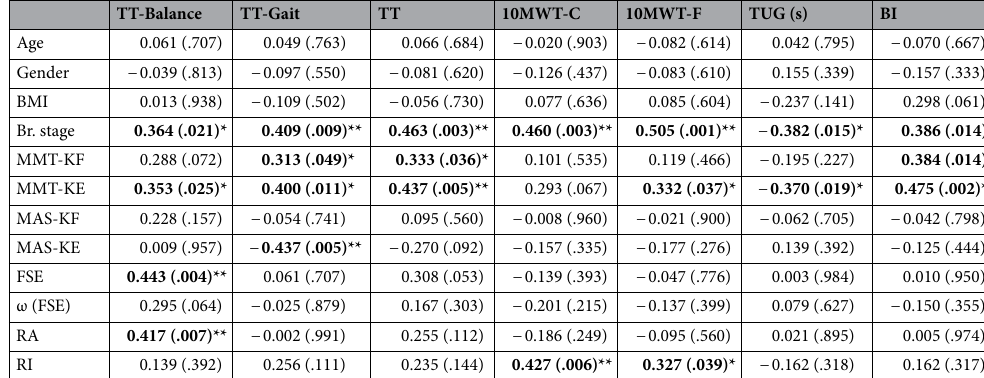
Table 3. Two-tailed Spearman correlation between MAS, pendulum parameters and mobility function. § BMI body mass index; Br. Stage Brünnstrom recovery stage; MMT manual muscle test; MAS modified Ashworth scale; KF knee flexor; KE knee extensor; FSE first swing excursion; ω(FSE) angular velocity of first swing excursion; RA resting angle of the pendulum test; RI relaxation index; TT Tinetti test; TT-Balance balance section of TT; TT-Gait gait section of TT; 10 MWT 10-m walk test; 10MWT-C comfortable speed of 10 MWT; 10MWT-F the fastest speed of 10 MWT; TUG timed-up-and-go test; BI Barthel index. *Correlation is significant at the 0.05 level (2-tailed); **Correlation is significant at the 0.01 level (2-tailed). a The MMT, MAS, and pendulum tests were investigated in the paretic knees (N = 40). b The strength of the monotonic relationship is presented by the correlation coefficient r s . p values are given in parenthesis. Significant correlation are presented in bold.